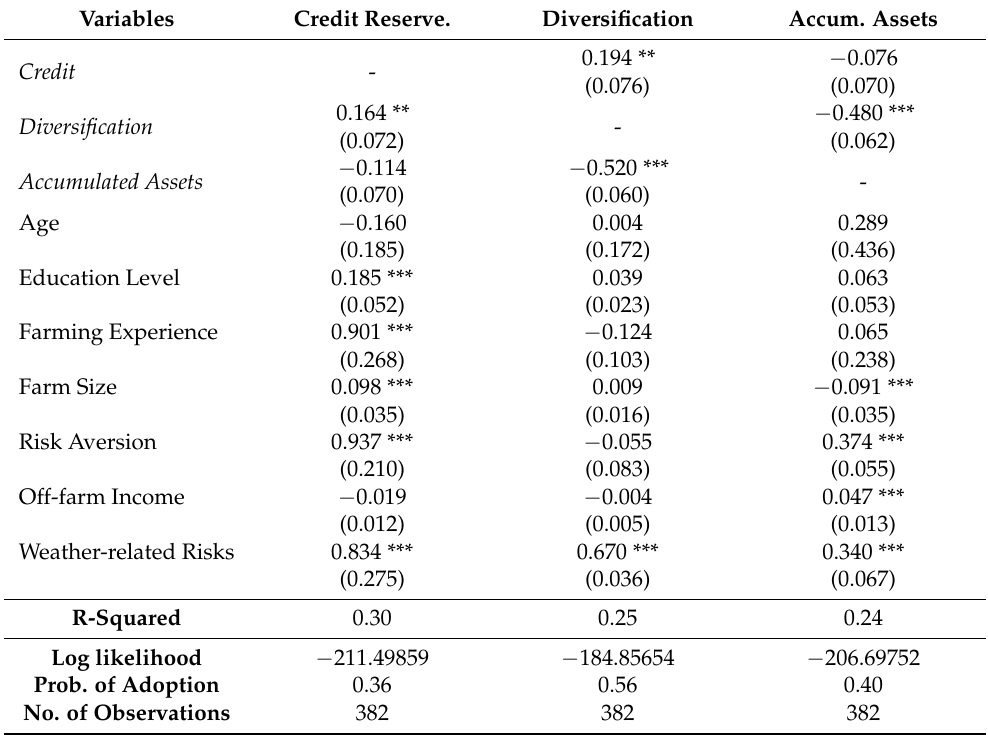
Table 13. Marginal effects of covariates on the adoption of RMS. Variables Credit